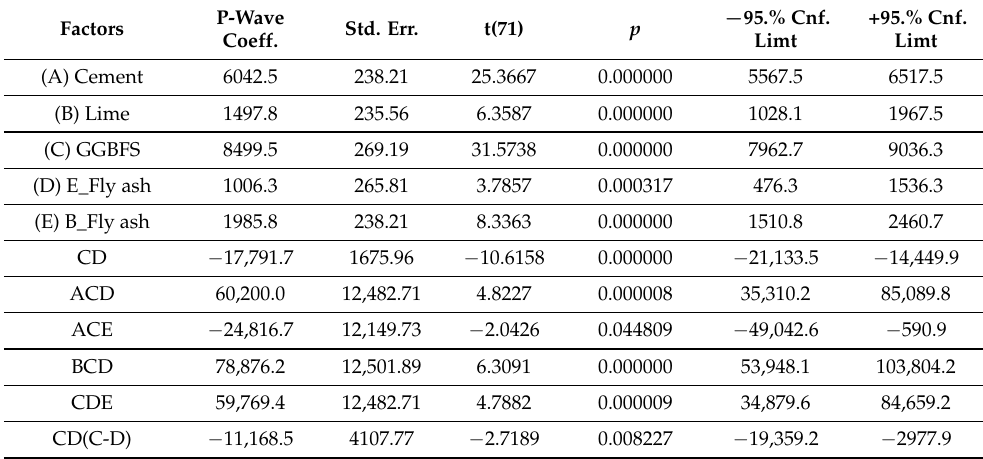
Table 8. Remaining significant effects on day 90th after backward